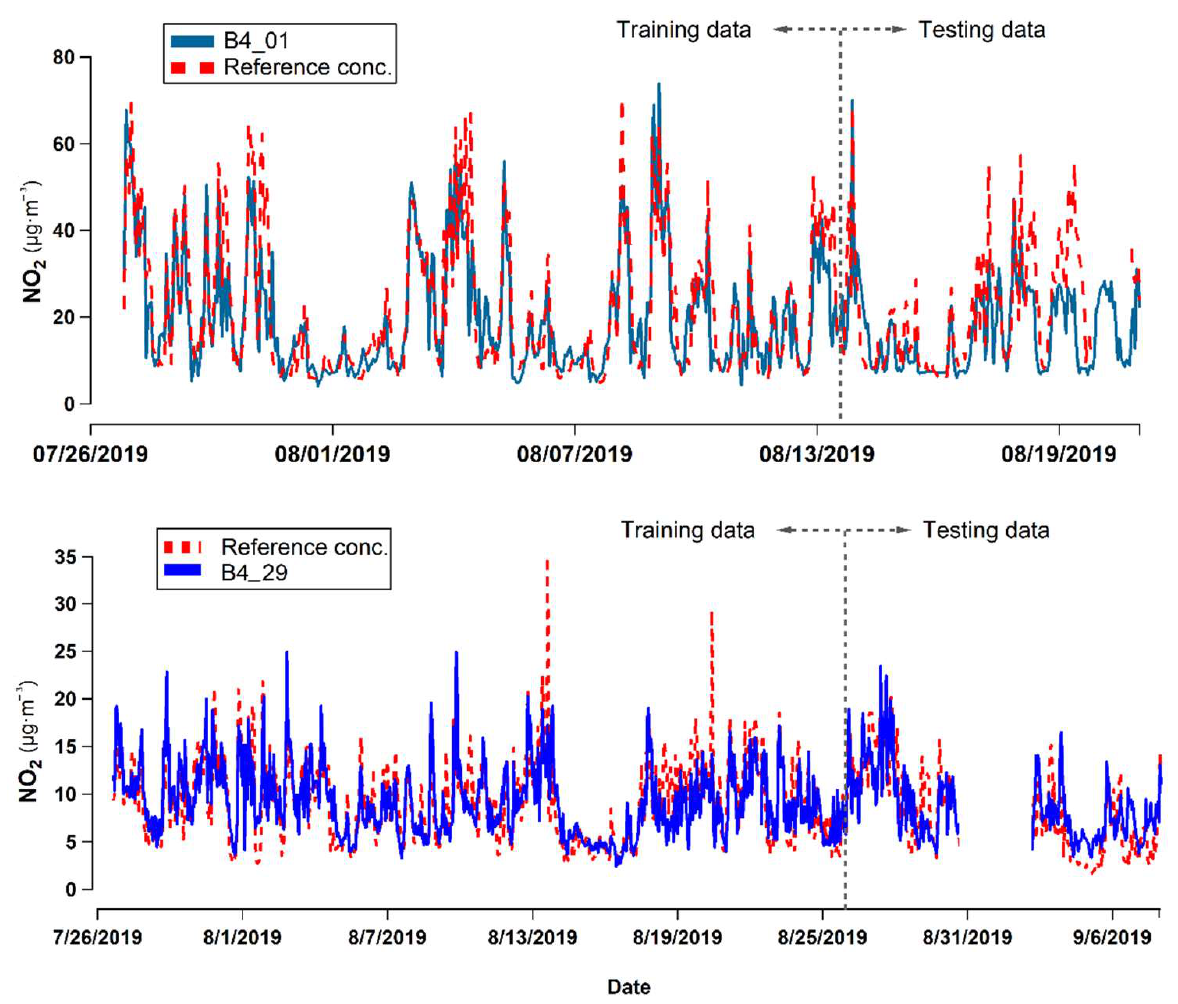
Figure 9. Scatterplots of NO 2 (1-h average) measured in the training campaign by the reference in- strument and the sensors (raw and calibrated response).